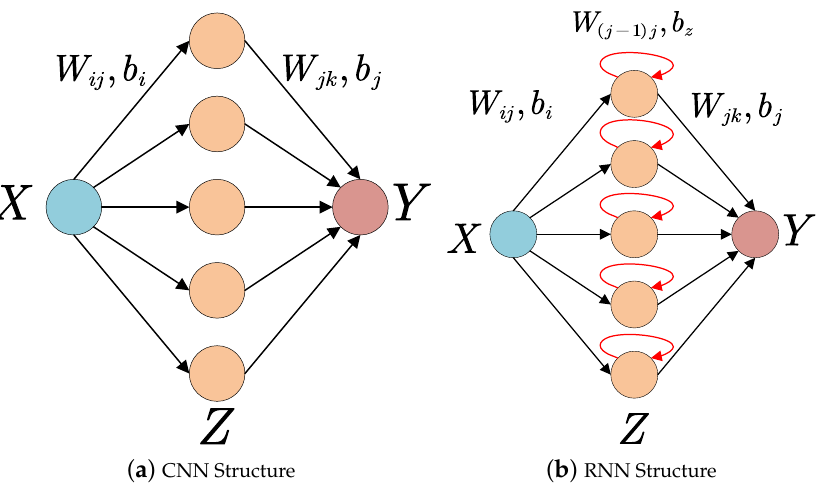
Figure 1. Comparison of two networks. ( a ) is the typical structure of Convolutional Neural Network (CNN), including Input Layers, Hidden Layers, and Output Layers. ( b ) is the structure of Recurrent Neural Network (RNN). Compared to ( a ), the Recurrent Edge is introduced to connect a Hidden Layer to itself across time.